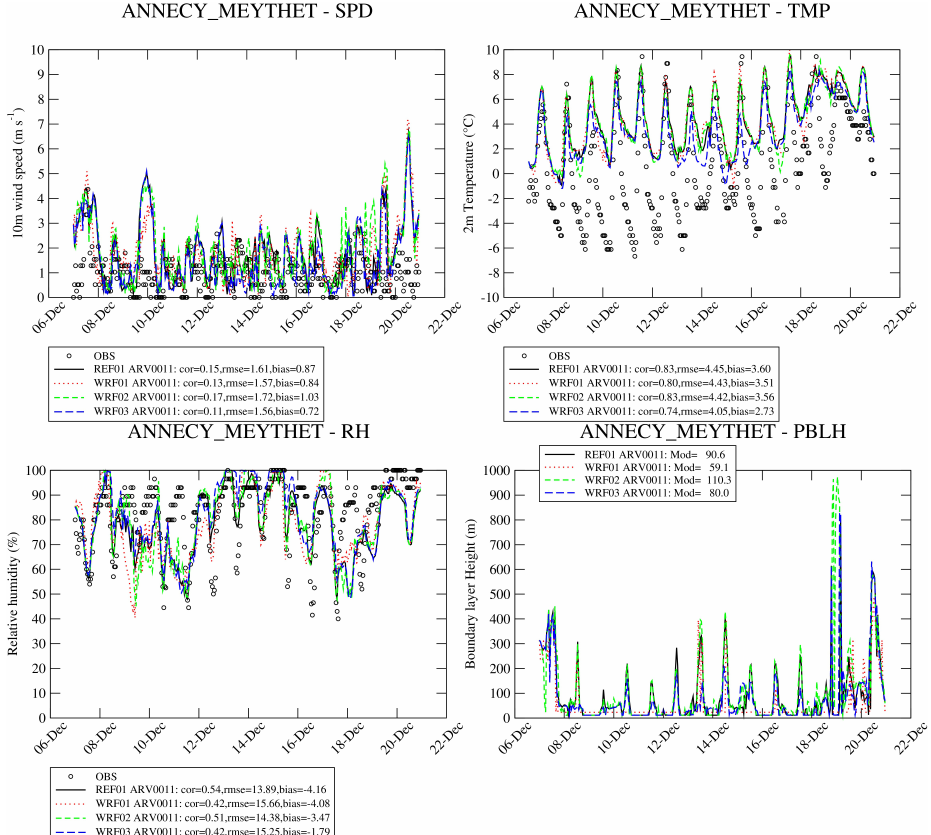
Figure 12. Impact of WRF settings on some meteorological variables at 1 ⁄ 90 ◦ resolution (ARV0011) for the EPII